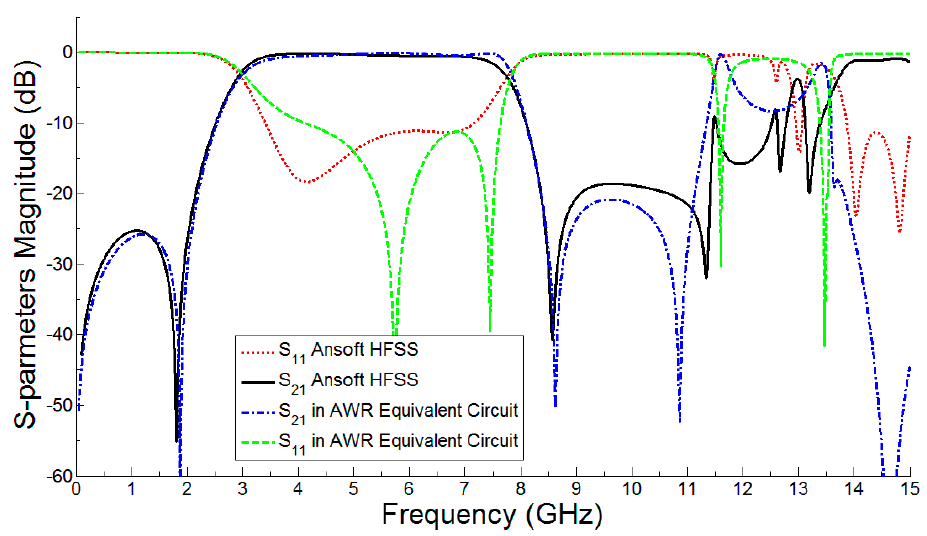
Figure 16. Frequency response comparison between HFSS and AWR for filter equivalent circuit validation.